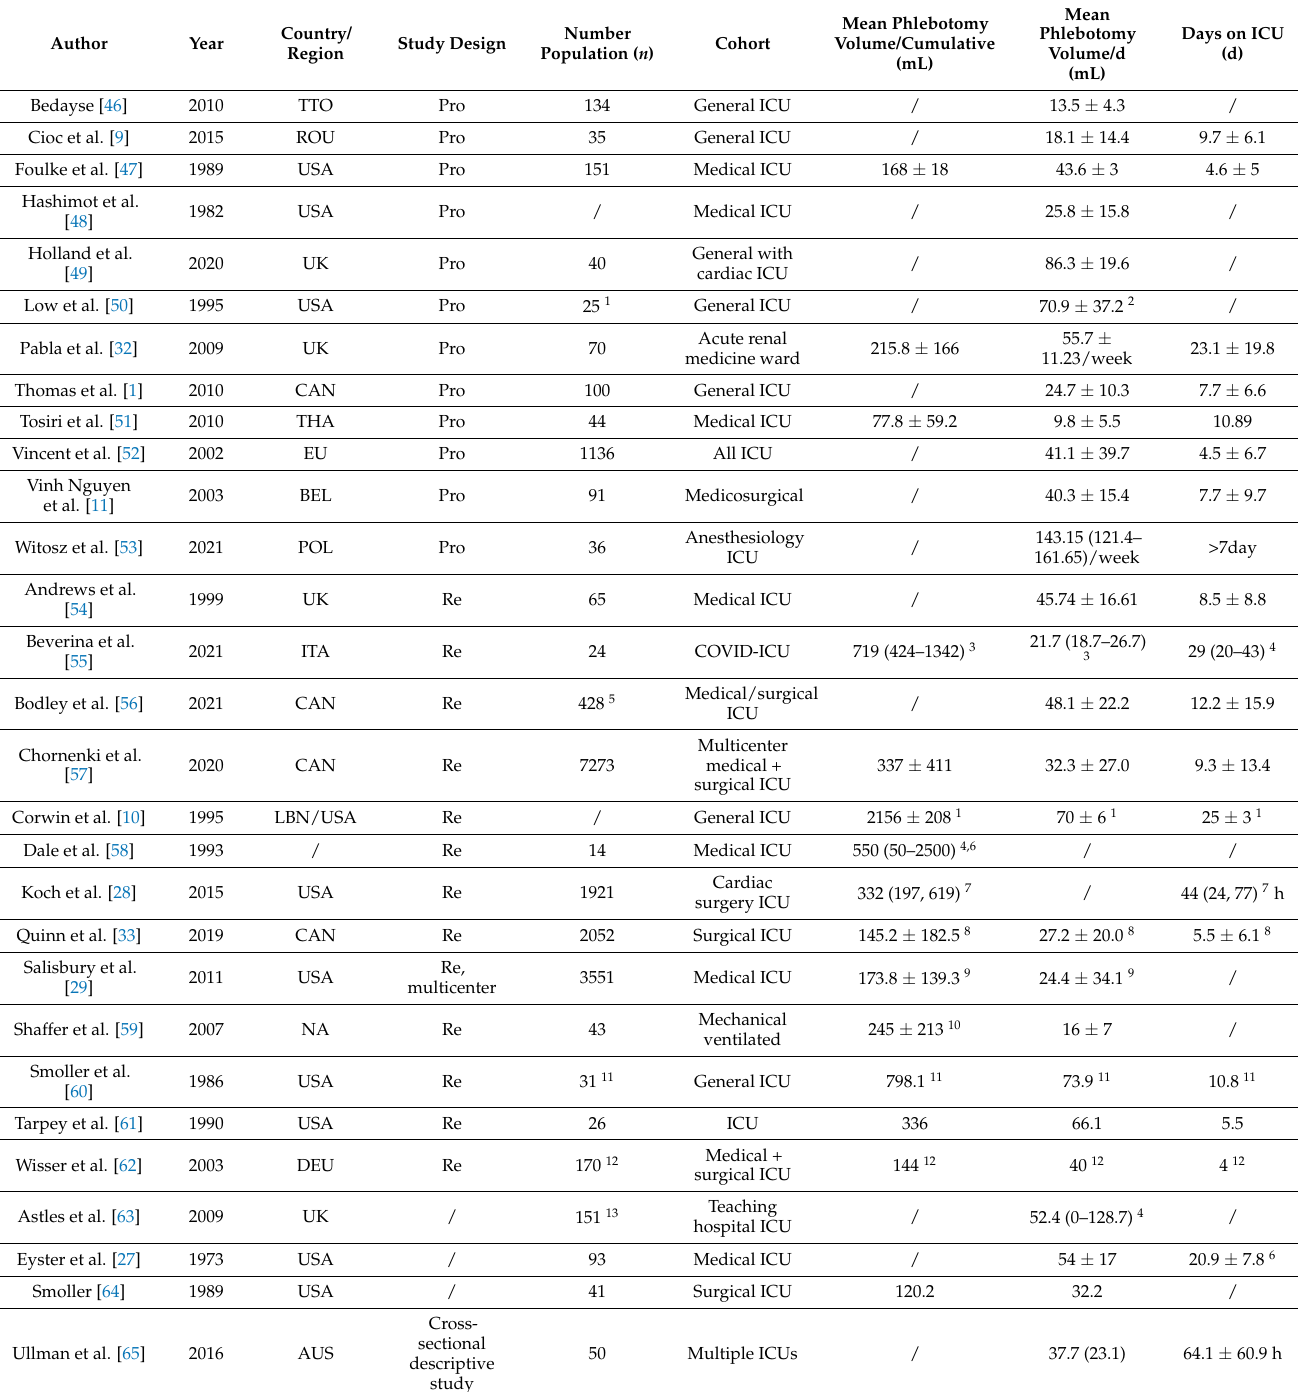
Table 3. Observational